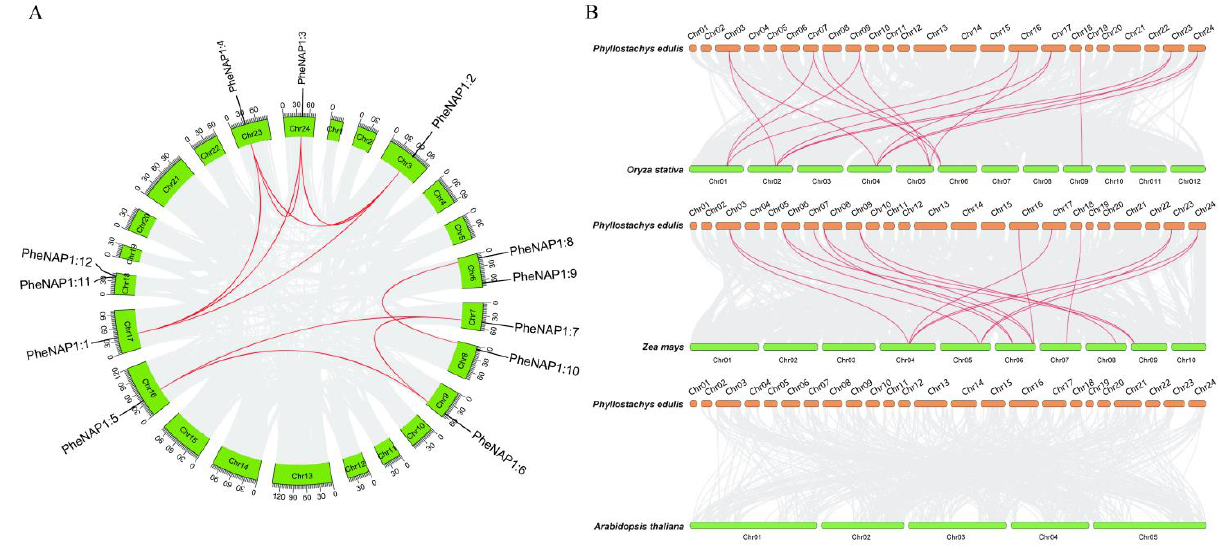
Figure 2. Chromosome location and synteny analysis of NAP1 genes in Phyllostachys edulis . ( A ) Synteny analysis of PheNAP1 genes. Red lines indicate duplicated NAP1 gene pairs; gray lines represent the synteny result of the moso bamboo genome. ( B ) Synteny analysis of NAP1 gene in Phyllostachys edulis and other plants. The gray lines in the background represent syntonic blocks of Phyllostachys edulis with Oryza sativa , Zea mays , and Arabidopsis thaliana , and the red lines represent syntonic NAP1 gene pairs.